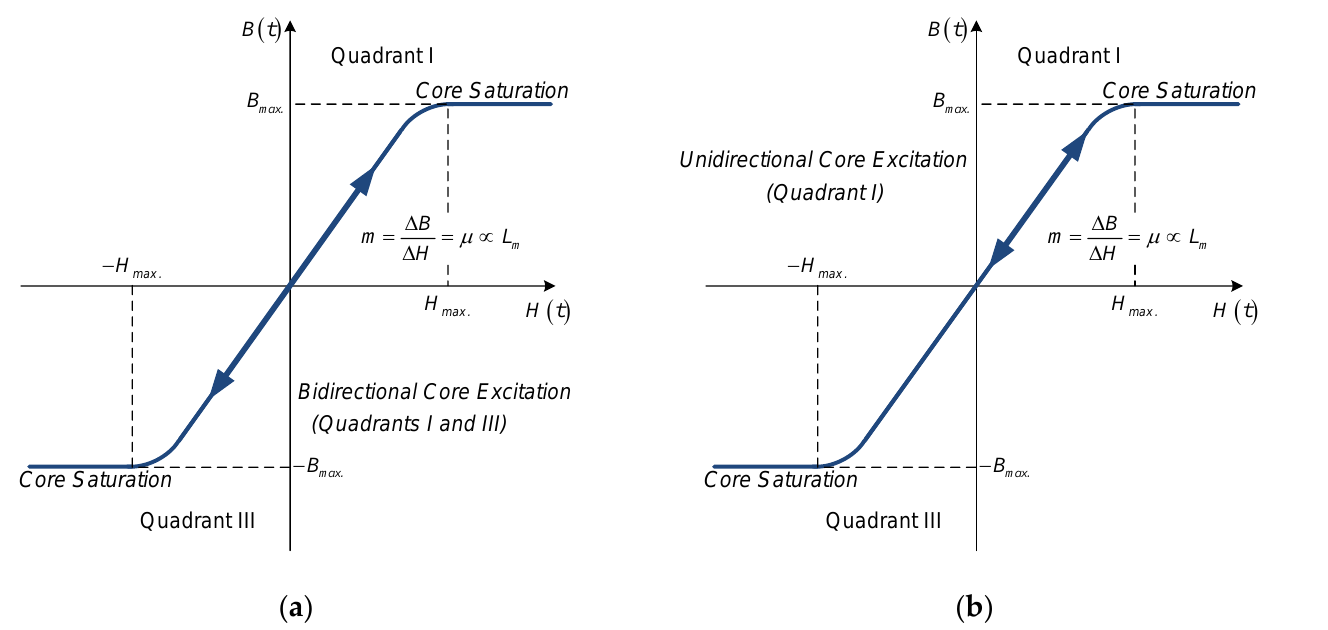
Figure 2. B - H Curve (without hysteresis) of Transformer Core. ( a ) Bidirectional Core Excitation. ( b ) Unidirectional Core Excitation.